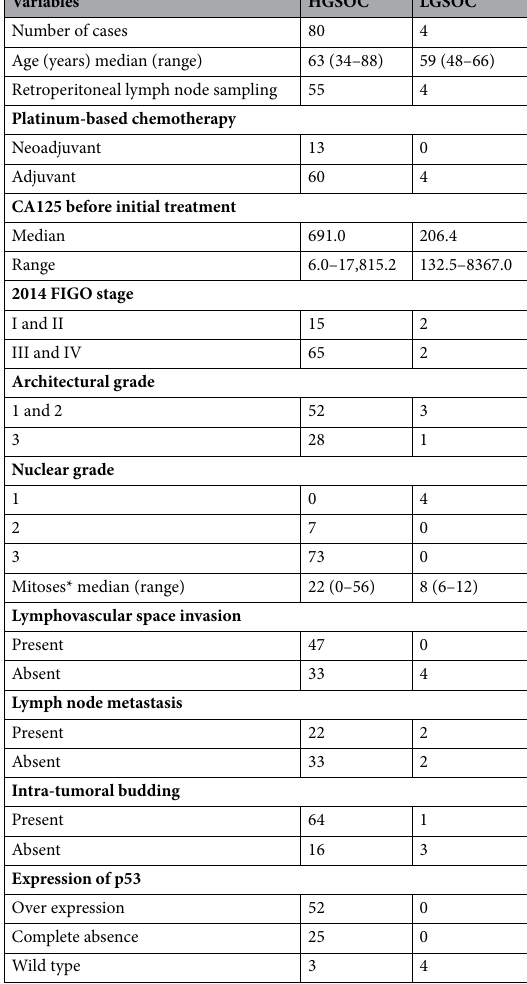
Table 1. ITB was found in 64 (80.0%) of the 80 HGSOCs and 1 (25.0%) of 4 LGSOCs. The values of CA125 level (P = 0.013), 2014 FIGO stage (P = 0.002), presence of lymph node metastasis (P = 0.049) and presence of LVSI (P < 0.001) in patients with HGSOC with ITB (Fig. 1) were significantly higher than those in patients with HGSOC without ITB (Fig. 2). The levels of CA125 before initial treatment and after 3cycles of cisplatin-based